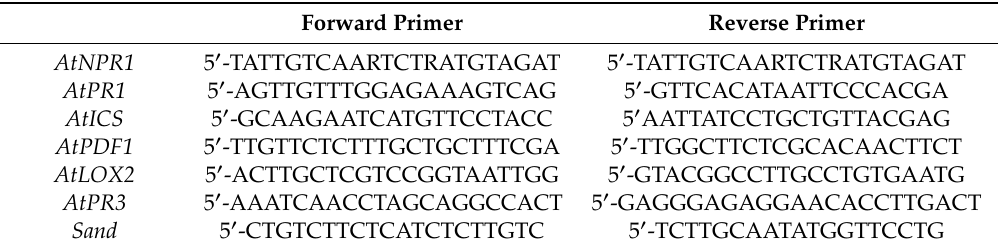
Table 2. Forward and reverse primers used in qPCR